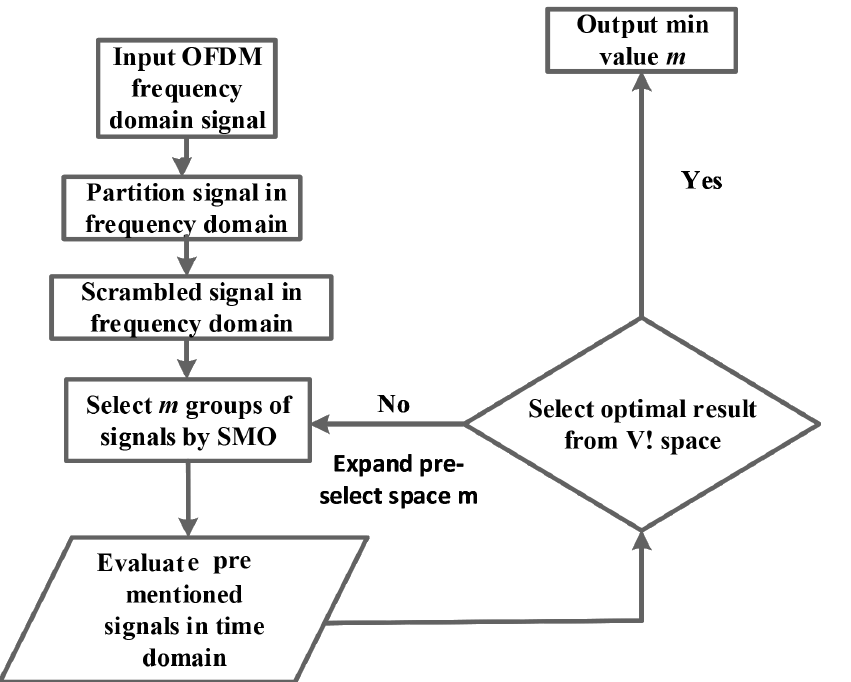
Figure 7. Flow chart of the FTD-PTS system.